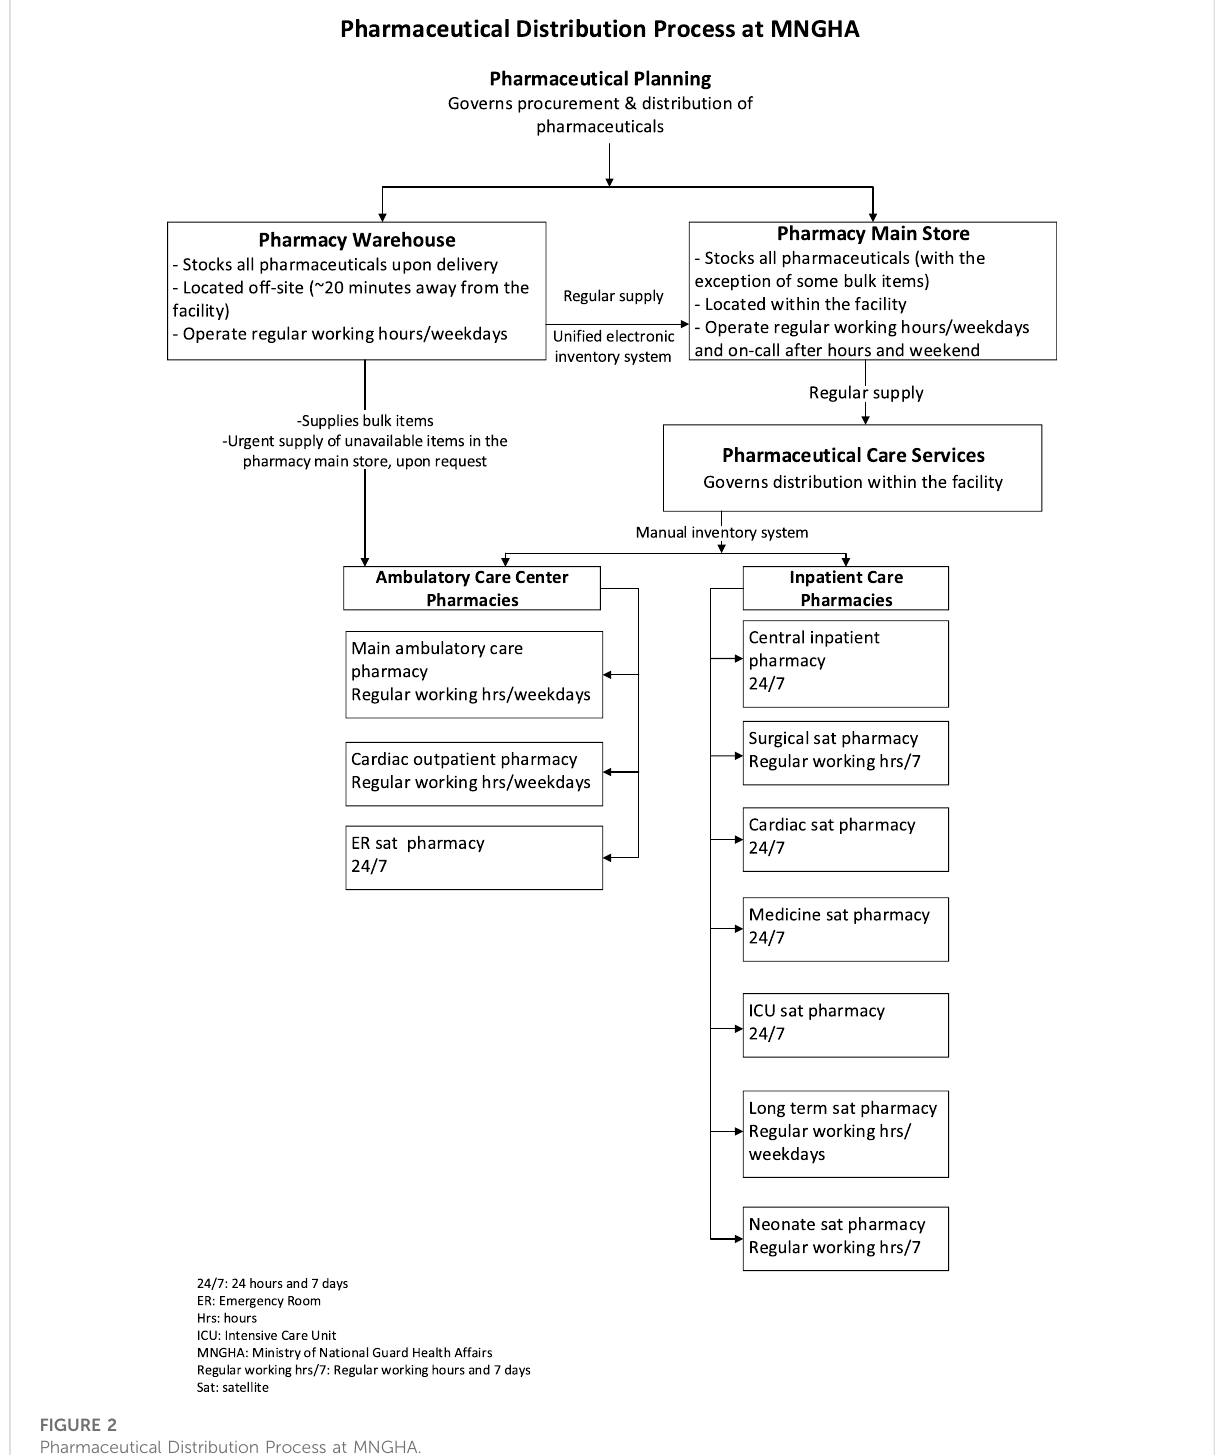
FIGURE 2 Pharmaceutical Distribution Process at